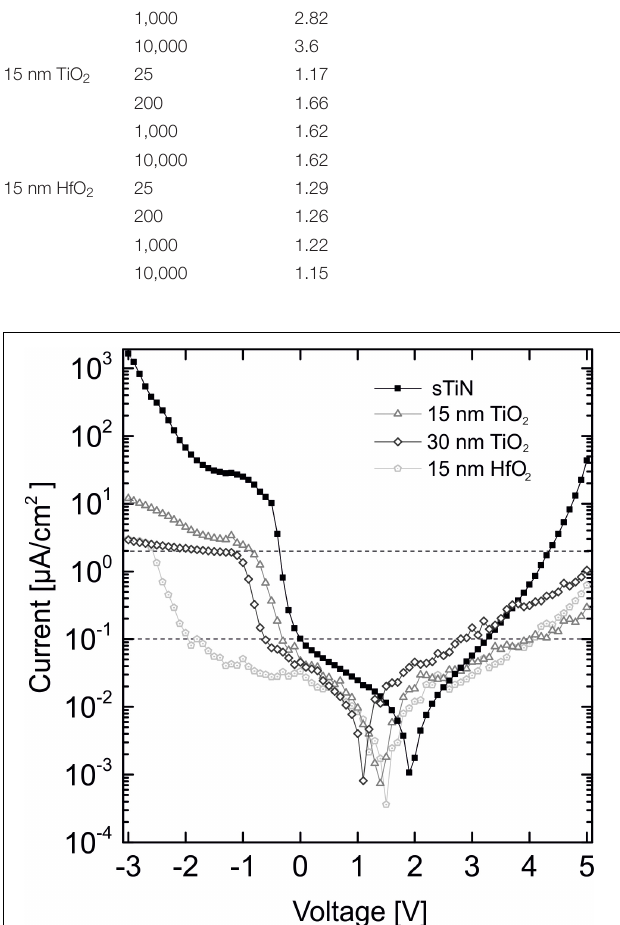
FIGURE 3 | Leakage current behavior of 15 and 30 nm TiO 2 on smooth TiN compared to 15 nm HfO 2 on TiN and an uncovered TiN electrode at an applied voltage range of +5 V to –3 V. Displayed threshold values of 0.1 µ A/cm 2 at ± 0.8 V [dynamic random access memory (DRAM) applications, International Technology Roadmap for Semiconductors (Aarik et al., 2012)] and the 2 µ A/cm 2 lowest stimulation threshold limit for cell stimulation (Eickenscheidt et al., 2012).